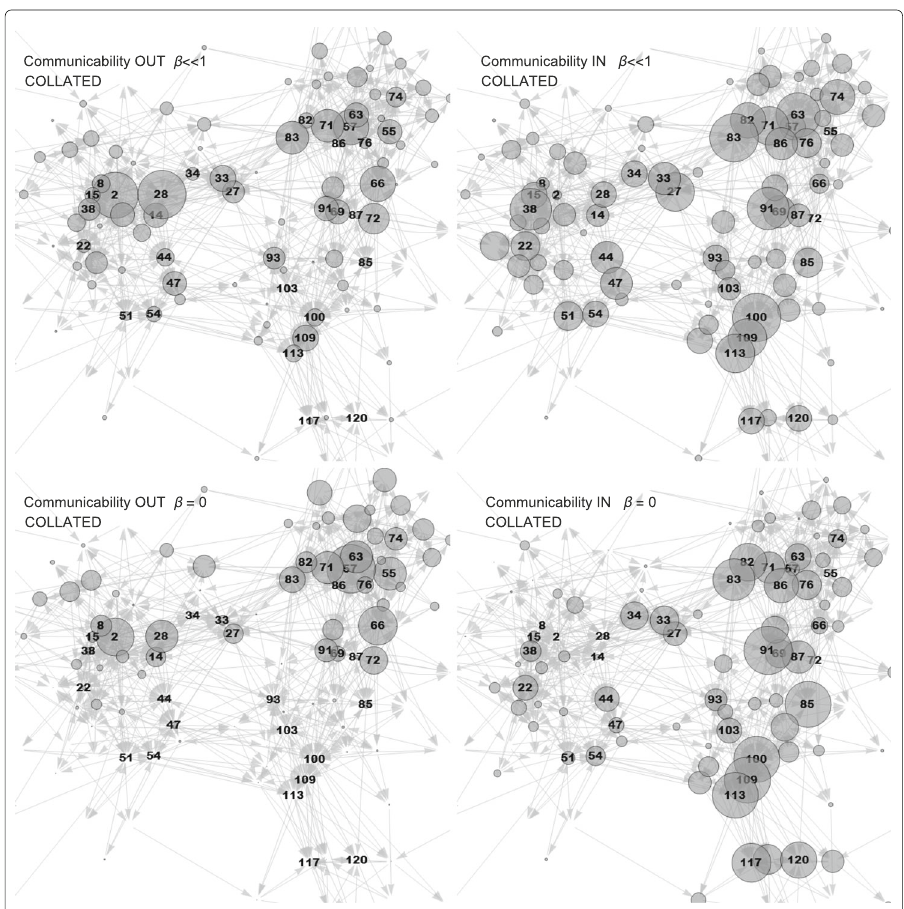
Fig. 2 Collated concept network. The 12 individual concept networks as collated into a single network. Nodes are shown in proportion to their out- and in-communicability. In the upper row node weighting is β = 10 − 2 and in the lower row β = 0. Note that only the part of the most importance is shown and